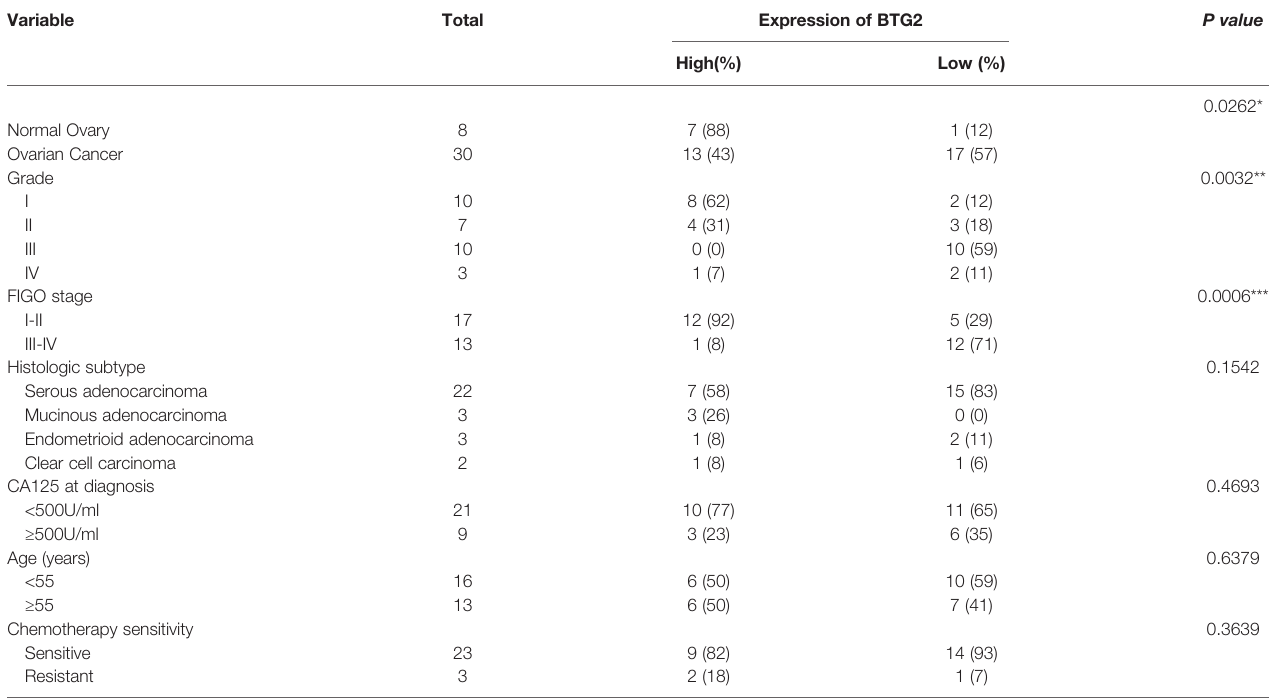
TABLE 1 | Clinical characteristics. Variable